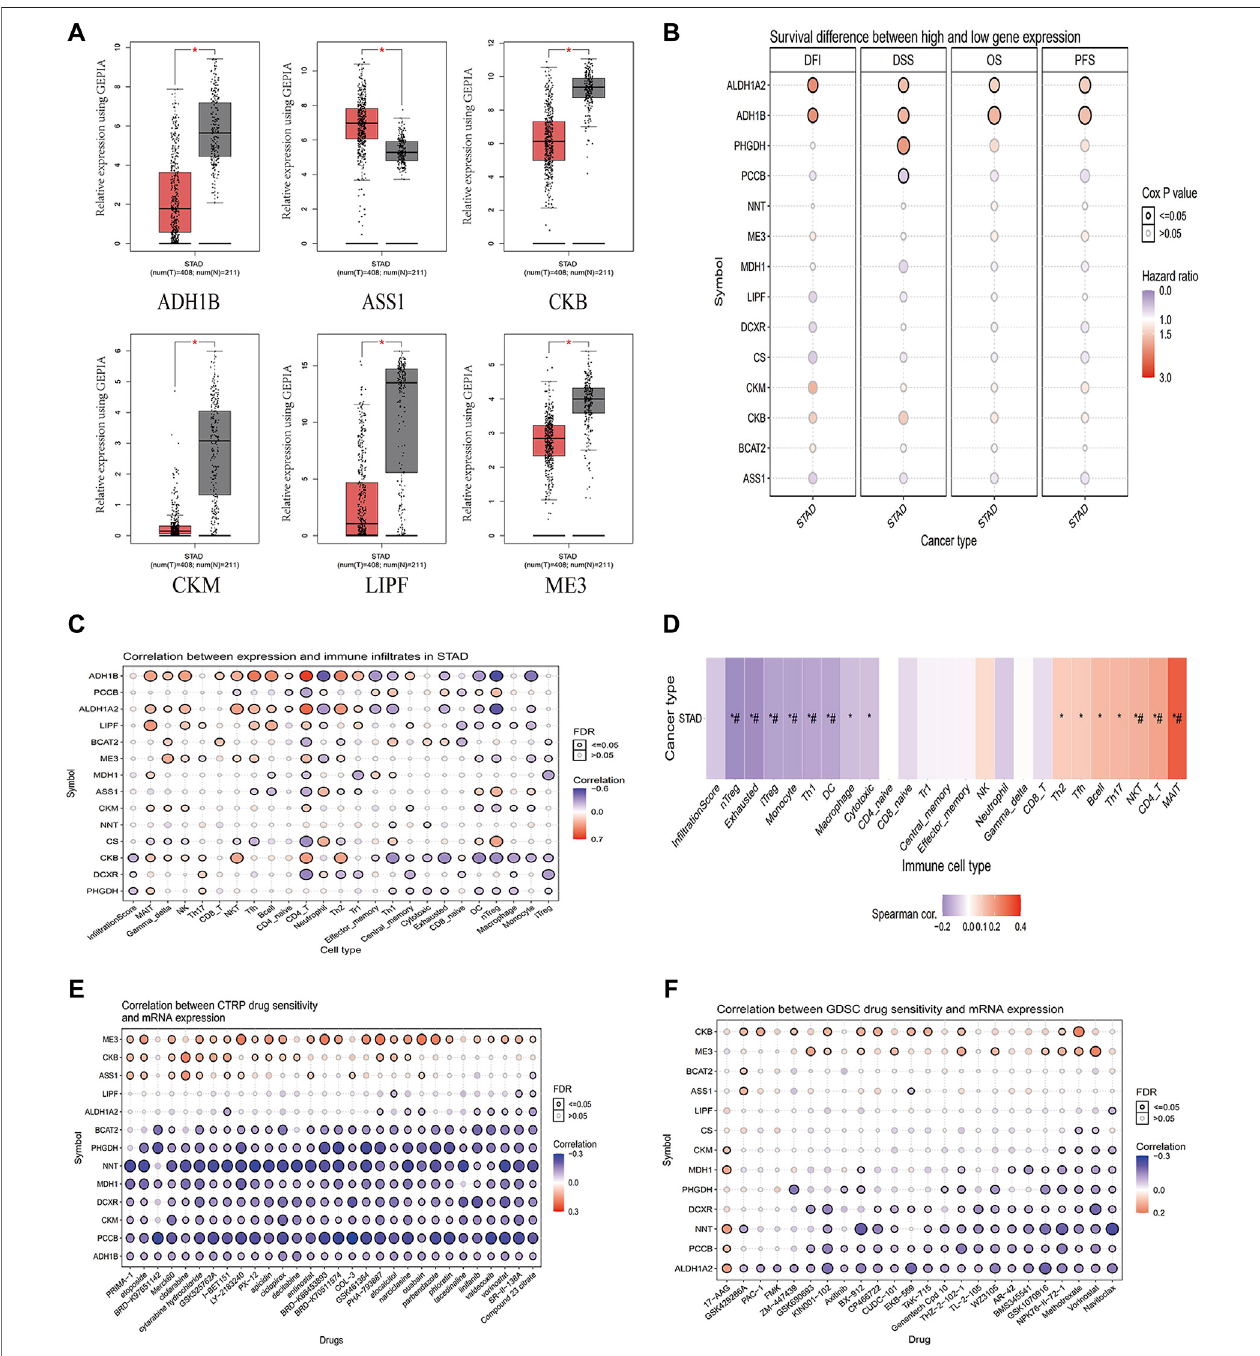
FIGURE3| Analysis of the correlation between 14 metabolic genes and immunity. (A) Analysis of signi fi cantly different genes in unpaired GC (T = 408) and normal tissues (N = 211) in the GEPIA ( p < 0.05). (B) Survival differential genes analysis in STAD from the GSCA database. (C) The correlation between 14 metabolic genes and immune cell in fi ltration in STAD from the GSCA database. (D) The correlation between a gene set composed of 14 metabolic genes and immune cell in fi ltration in STAD from the GSCA database. (E) Correlation analysis of 14 metabolic genes and CTRP drug sensitivity from the GSCA database. (F) Correlation analysis of 14 metabolic genes and GDSC drug sensitivity from the GSCA database. T, GC tissues; N, matched adjacent normal samples.